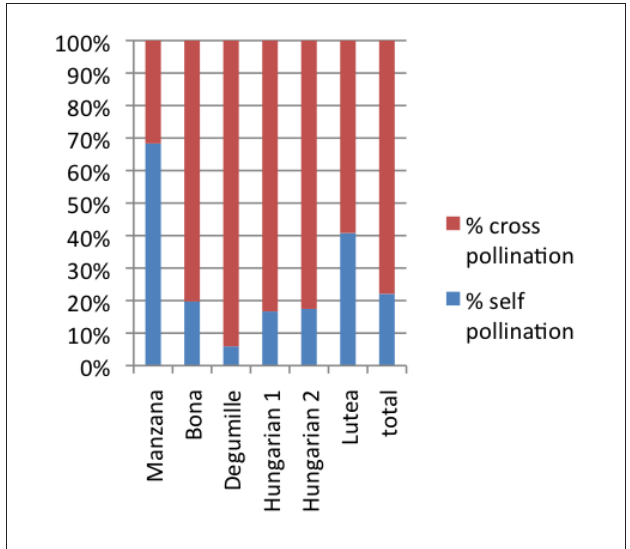
Fig. 2: Calculated percentages of self- and cross-fertilization under open pollination conditions, based on the means of produced seeds per flower head under isolation and under open pollination